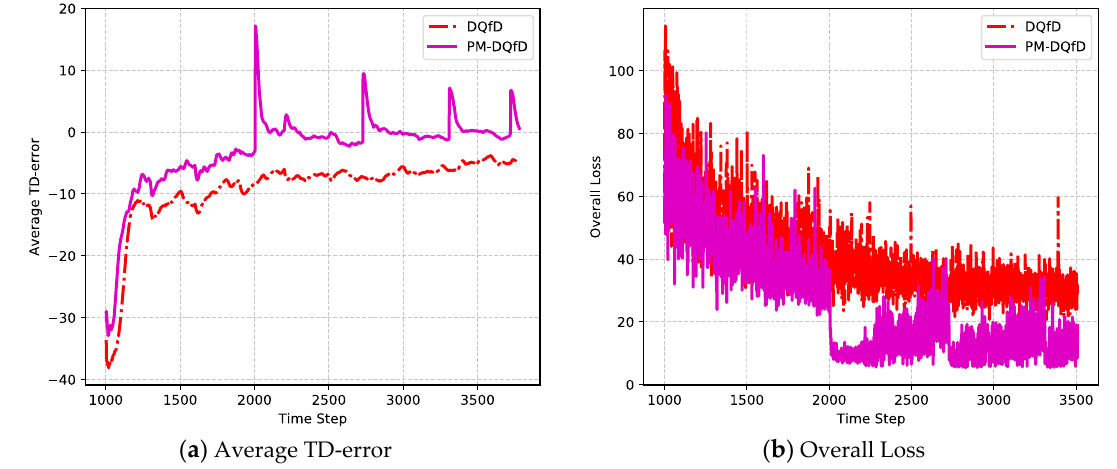
Figure 7 (a,b). Data efficiency of the natural DQfD and PM-DQfD versus time step. Figure 7. ( a , b ) Data e ffi ciency of the natural DQfD and PM-DQfD versus time